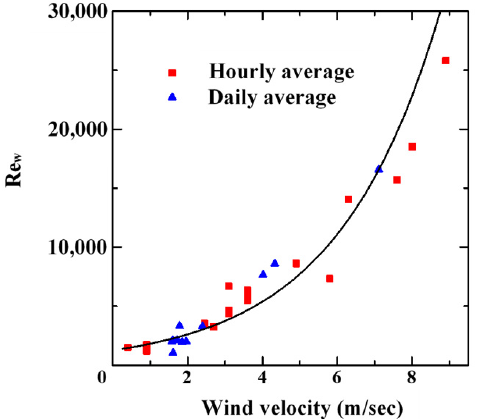
Figure 20. The relationship between the wind velocity and Reynolds number observed in the field.